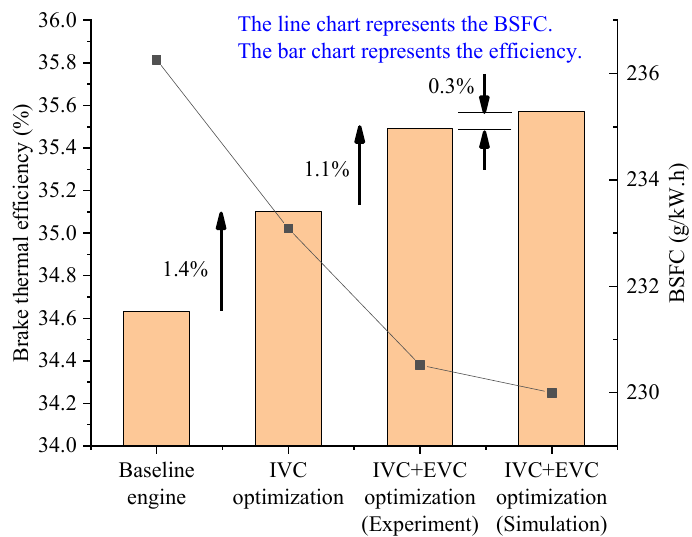
Figure 25. BSFC and brake thermal efficiency improvement after the baseline engine accomplishes each optimization stage (point of operation: n = 3000 rpm, BMEP = 10 bar, CA50 = 8 °CA).